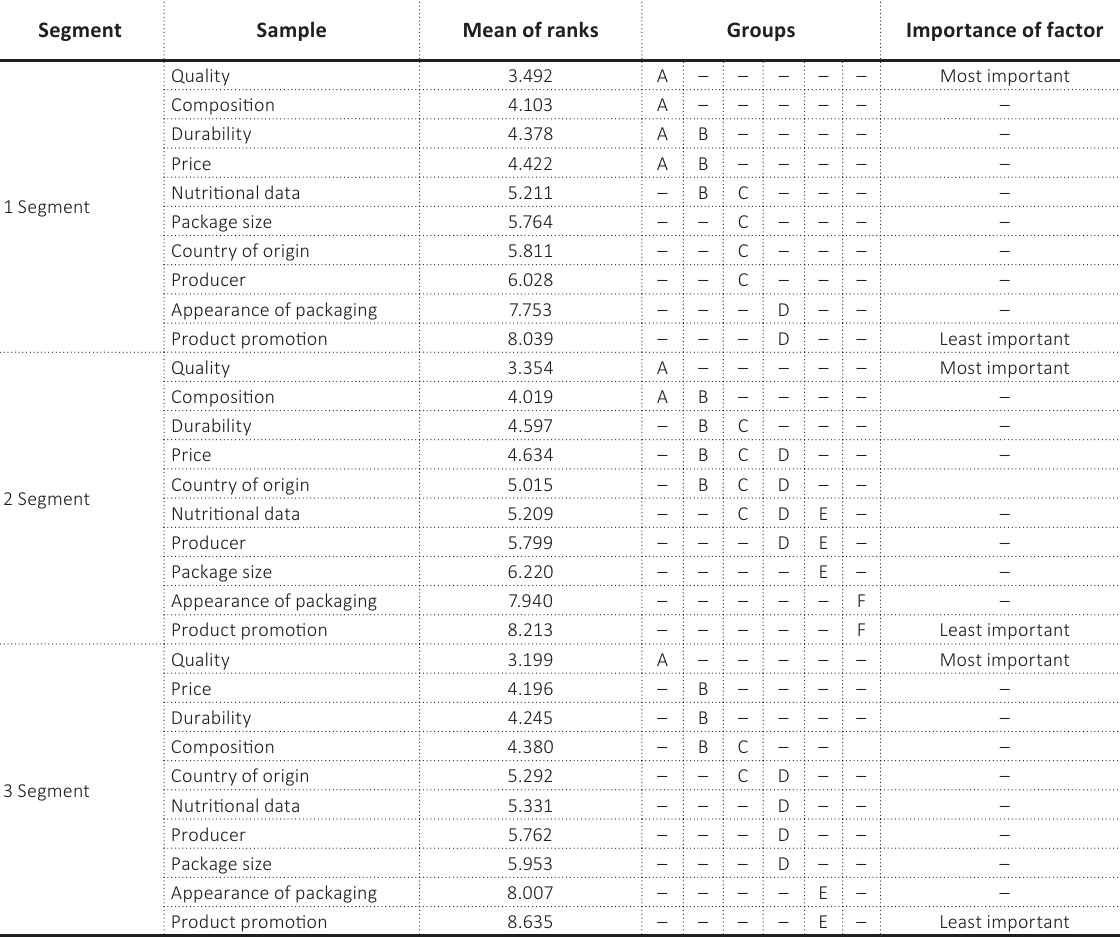
Table A7. Differences in the assessment of factors determining the level of consumption of milk and dairy products by